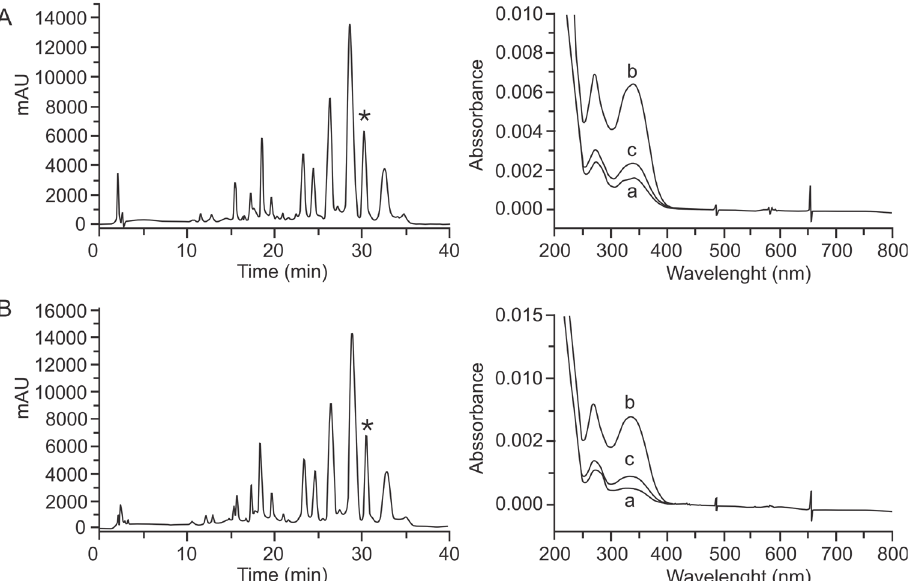
FIGURE 6 - A) Left: chromatogram of the methanolic extract. Isovitexin peak is marked with a (*). Right: spectra of isovitexin peak at the (a) beginning (b) top and (c) end. B) Left: chromatogram of the glycolic extract. Isovitexin peak is marked with a (*). Right: spectra of isovitexin peak at the (a) beginning (b) top and (c)